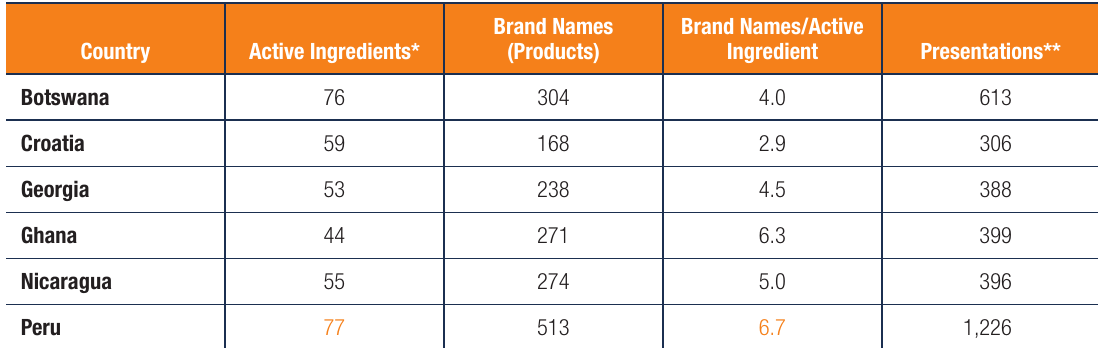
FIGURE A9.2. Single-Compound Antibacterial Products